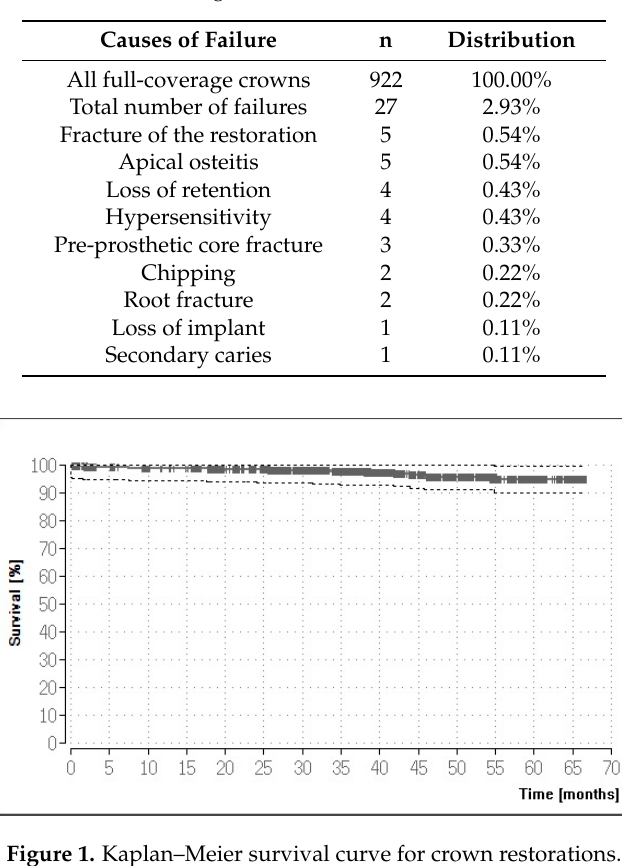
Table 5. Reasons for biological or technical failure of crown restorations.